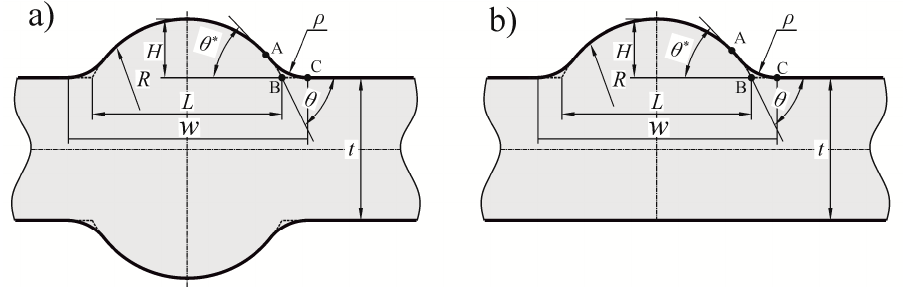
Figure 1. Shape and basic parameters of the butt welded joints: ( a ) a Double-V and ( b ) a Single-V.